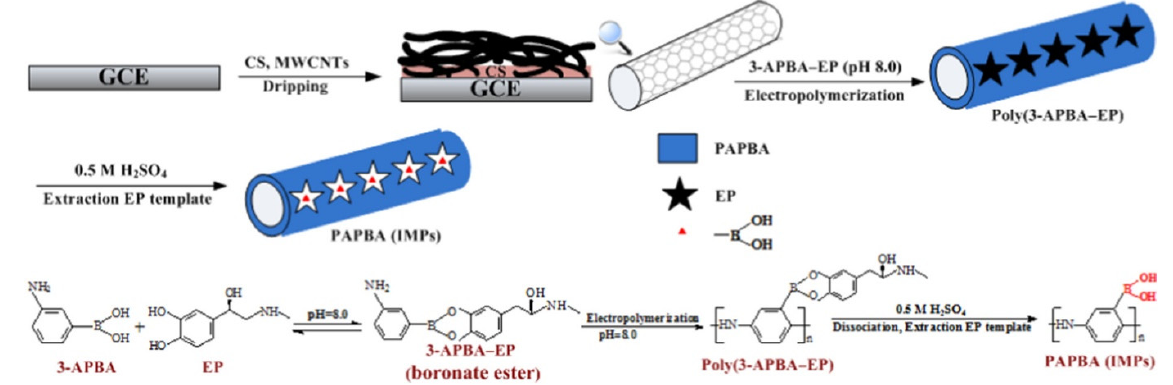
Figure 5. Graphical depiction of the constructed EP ‐ imprinted biosensor preparation. Reprinted with permission [109]. Copyright 2019 Elsevier.